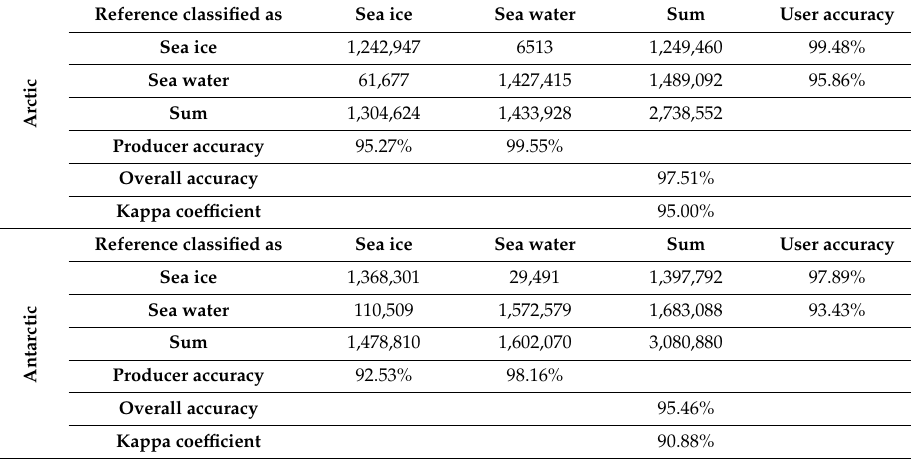
Table 2. The confusion matrix for the decision tree (DT) algorithm using data from Arctic and Antarctic regions.